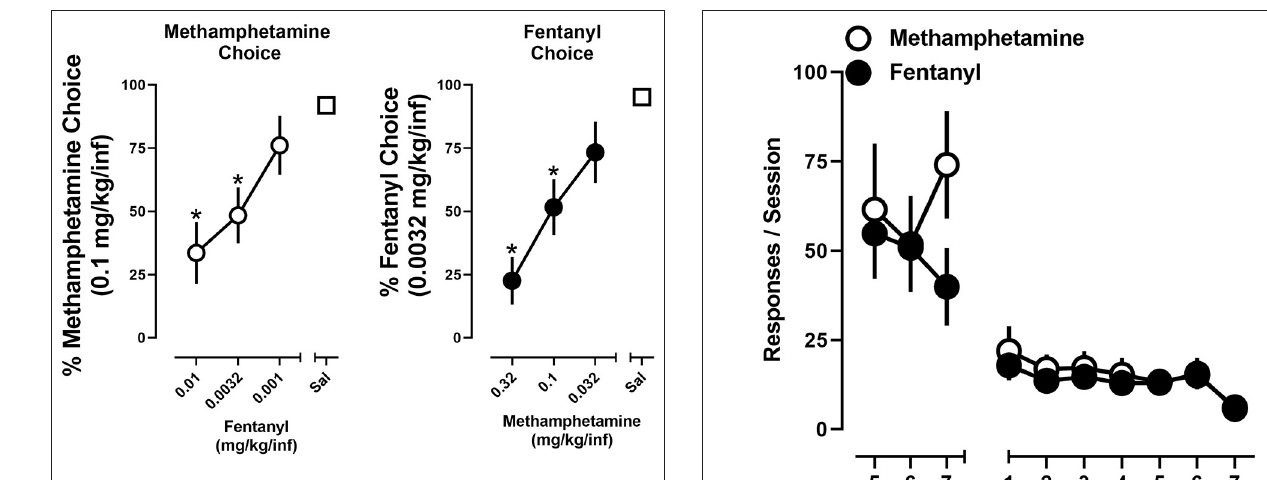
on the methamphetamine and fentanyl levers, respectively ( Figure 6 ;